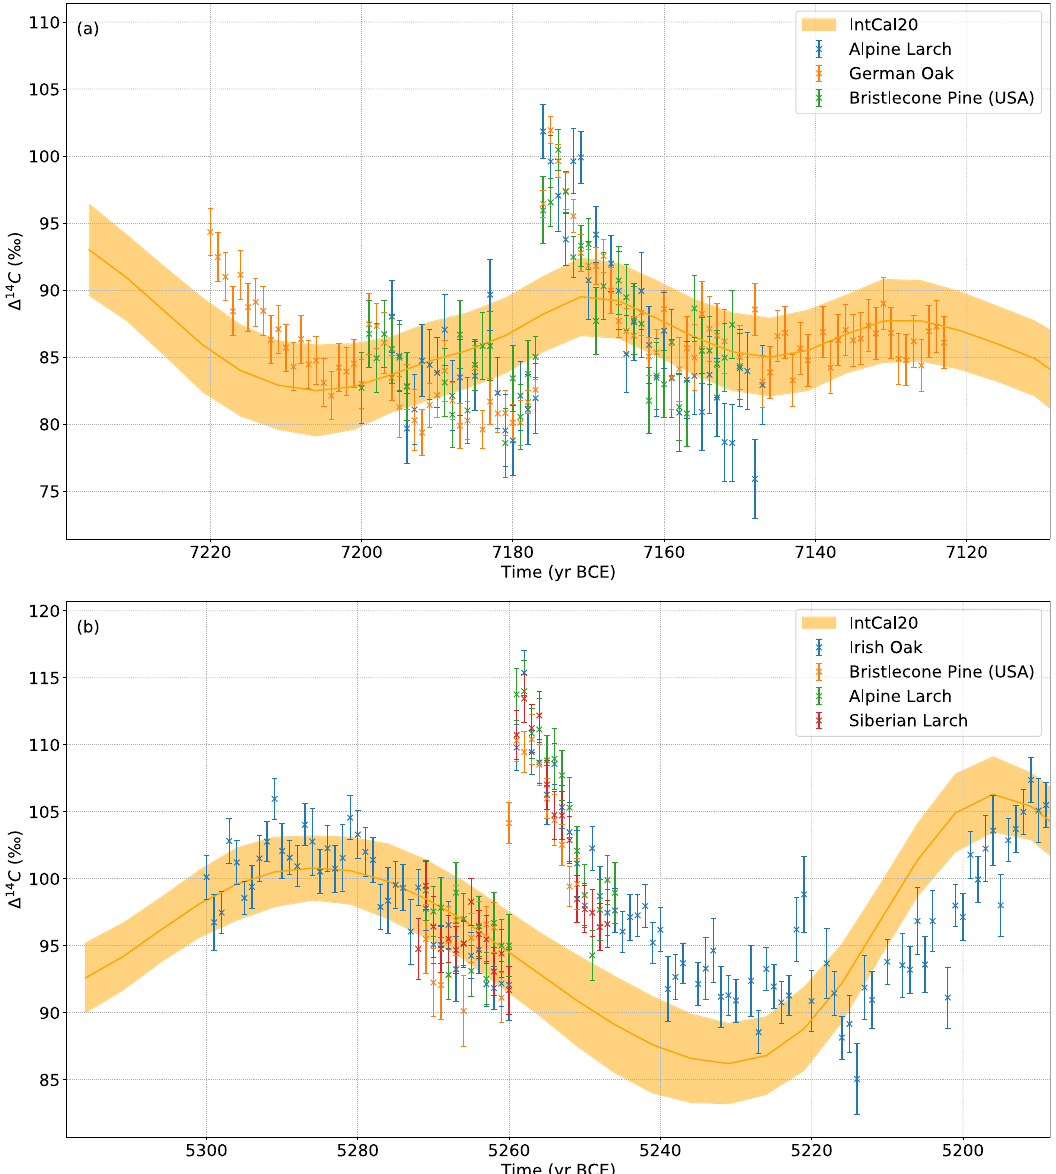
Fig. 1 14 C data of the two events compared to IntCal20. Annual 14 C concentrations reported as Δ 14 C with 1- σ errors from different trees for the two found events (7176 BCE ( a ), 5259 BCE ( b )) in comparison with the IntCal20 calibration curve 27 (orange